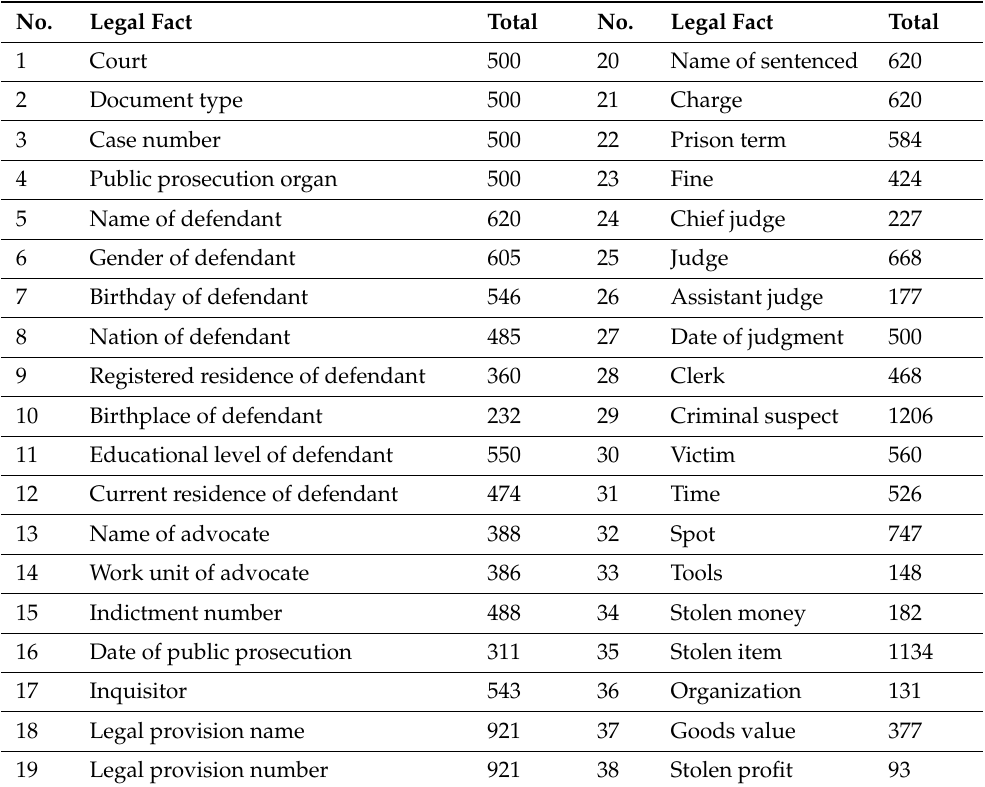
Table 2. Statistics of the judicial